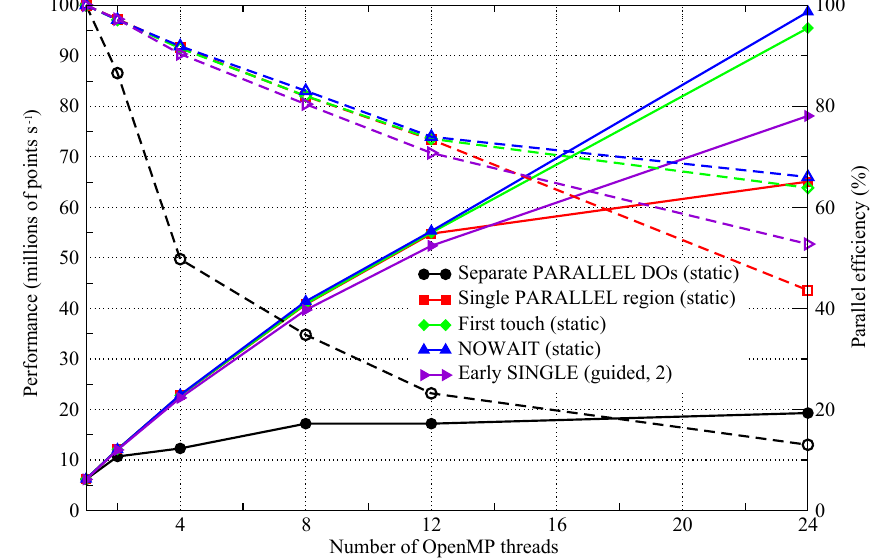
Figure 8. Performance of the OpenMP-parallel version of PSyKAl NEMOLite2D for the Intel compiler on a single Intel Ivy Bridge socket. The corresponding parallel efficiencies are shown using open symbols and dashed lines. The 24-thread runs employed hyperthreading and the optimal OpenMP schedule is given in parentheses.